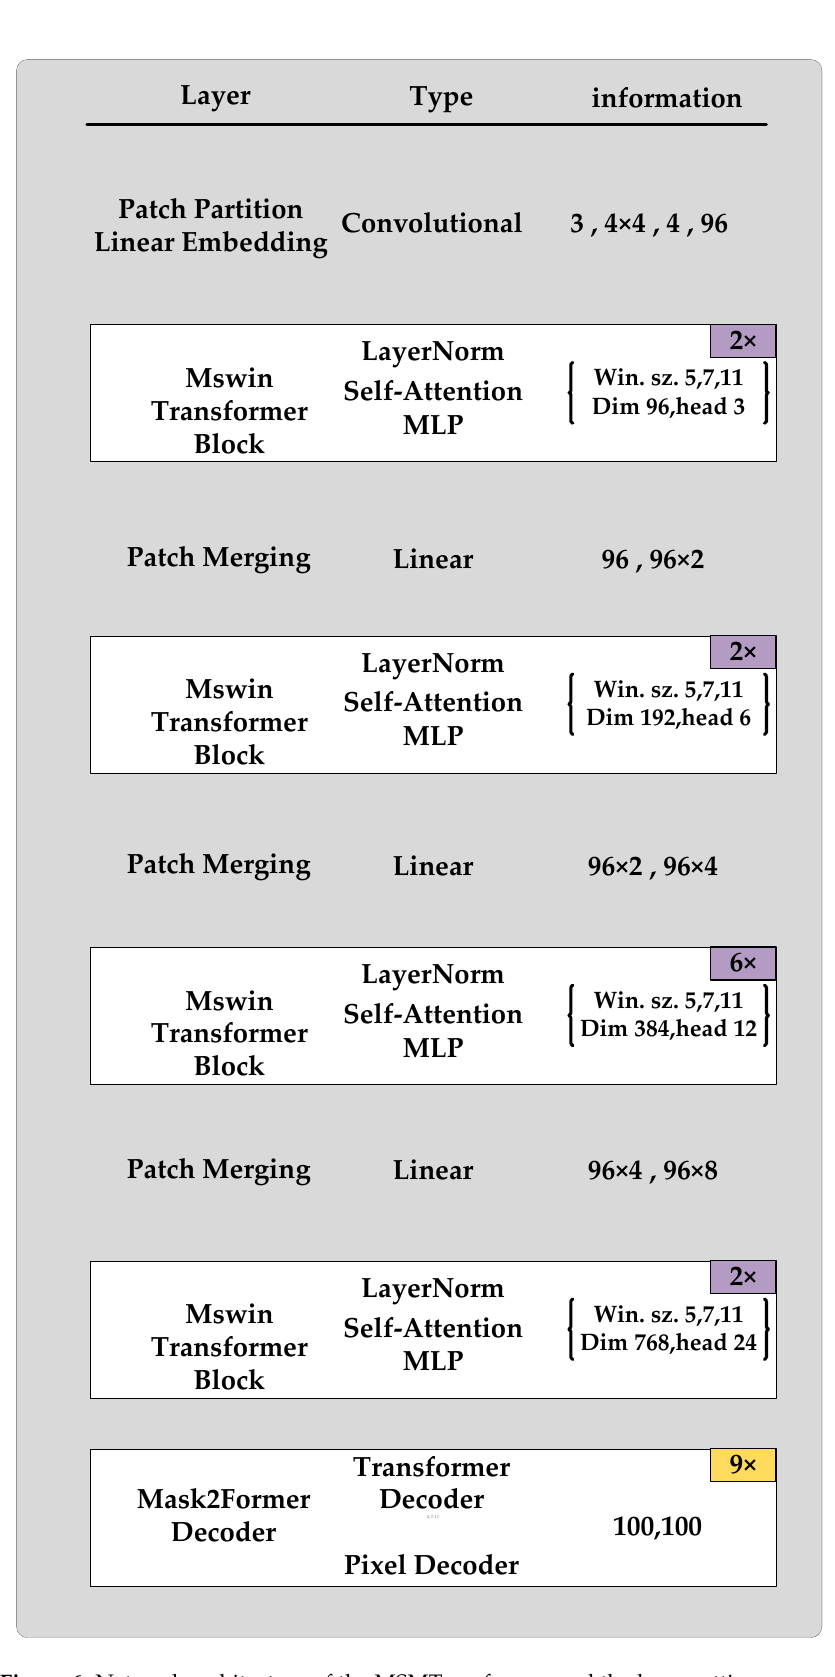
Figure 6. Network architecture of the MSMTransformer and the layer settings.